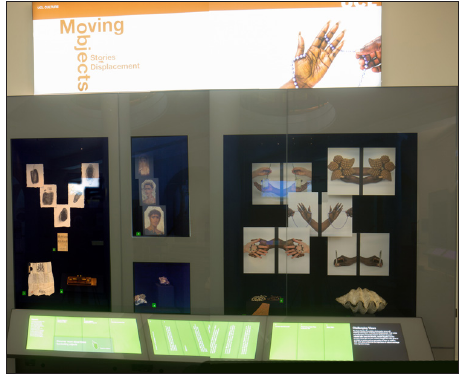
Figure 5: The Challenging Views case in the Moving Objects exhibition (Photo: Stuart